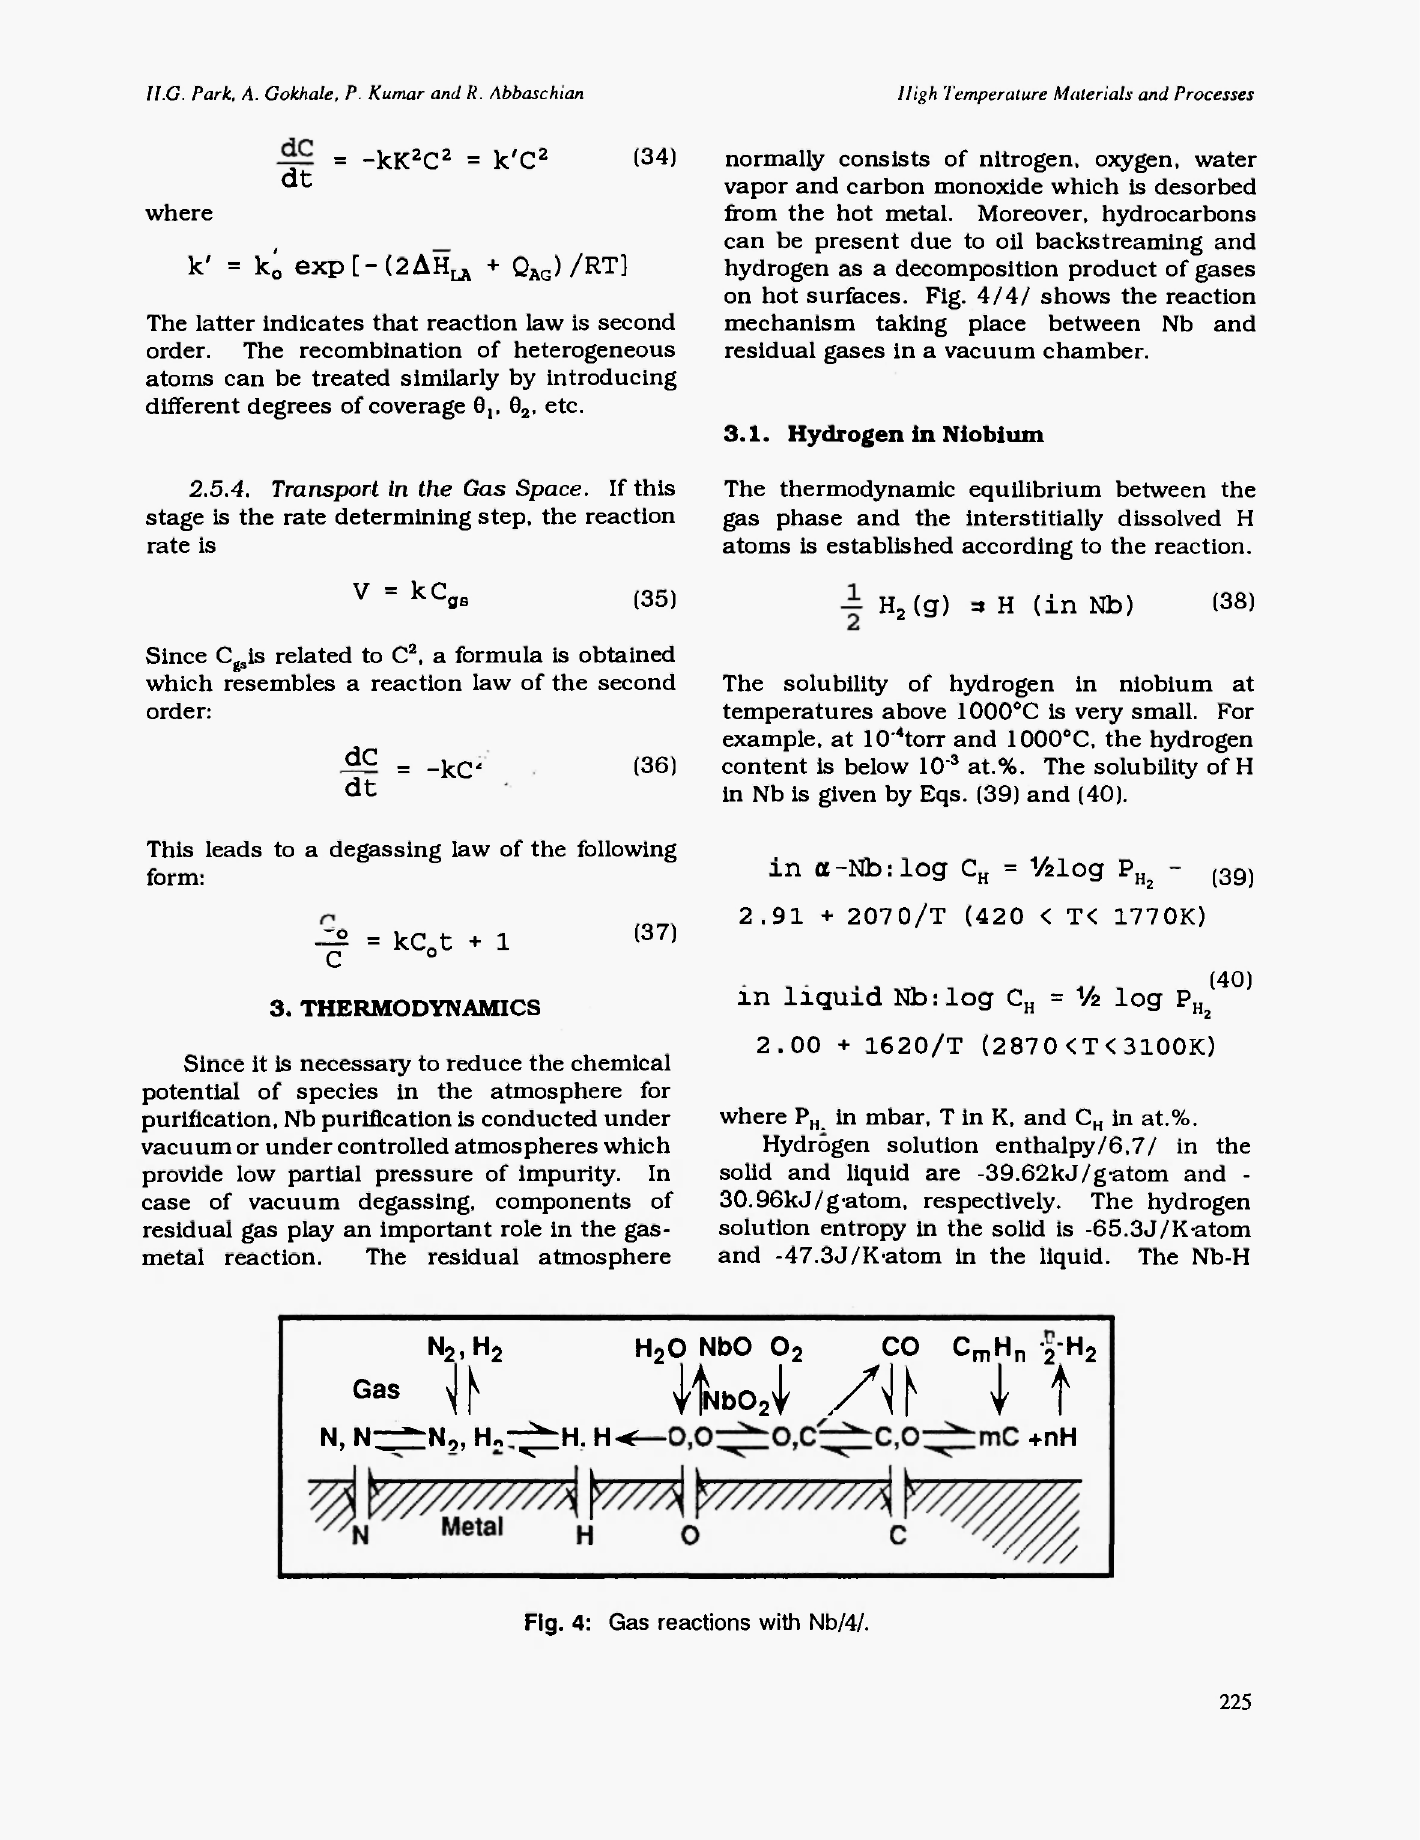
Fig. 4: Gas reactions with